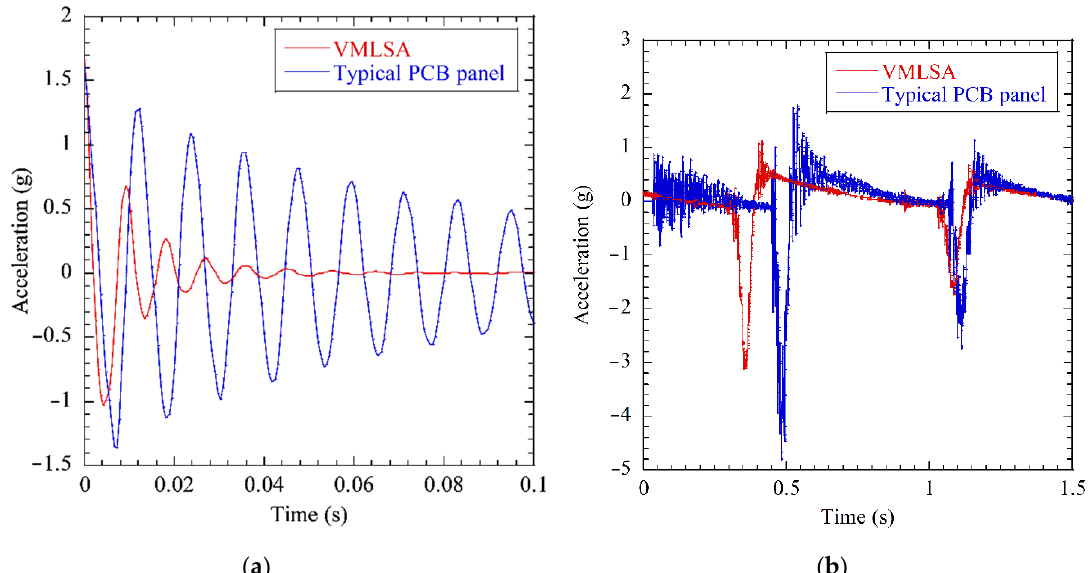
Figure 9. Dynamic characteristics investigation results of the solar panels: ( a ) time histories of free-vibration response in rigidly mounted condition and ( b ) acceleration profile under deployment.